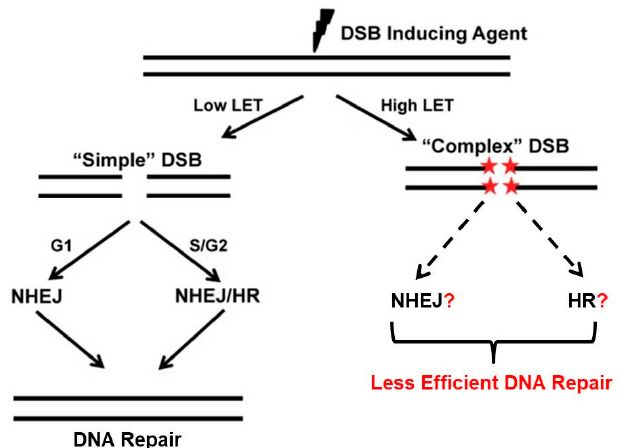
Figure 3. Repair of high- and low-LET radiation-induced DNA damage. Low-LET radiation-induced DNA double-strand breaks (DSBs) are typically repaired by non-homologous end joining (NHEJ) or both NHEJ and homologous recombination (HR) if cells are in S or G2 phases of the cell cycle. The repair of complex DSBs generated by high LET radiation including carbon ions is poorly understood. The less efficient repair response after high-LET radiation leads to DNA damage remaining unrepaired for long periods of time and eventually may promote genome instability and cell